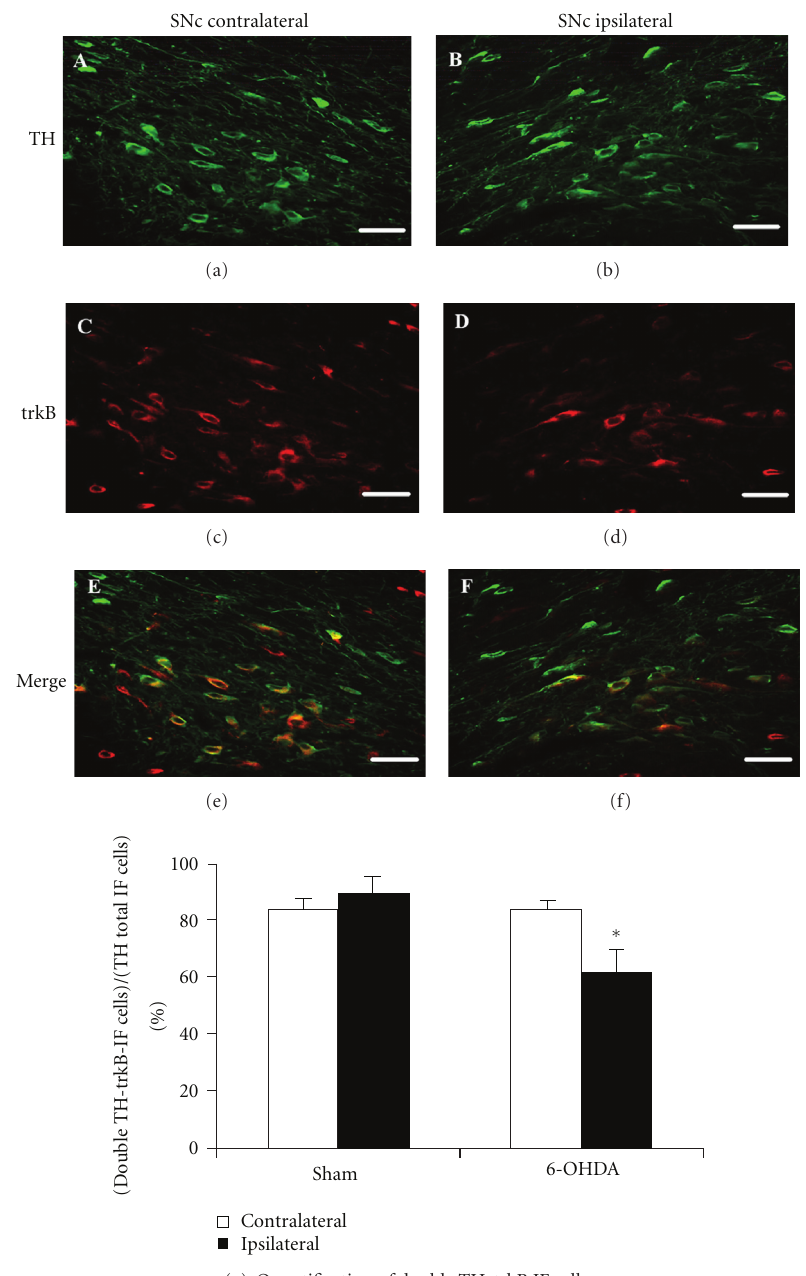
Figure 6: A decrease in the percentage of double labeling for TH and trkB in SNc is detected 7 days after unilateral 6-OHDA intrastriatal injections. Photomicrographs show TH-IF cells (a), (b) and trkB-IF cells (c), (d) in rat SNc, 7 days after unilateral 6-OHDA intrastriatal injection. (e) Merge of (a) and (c); (f) merge of (b) and (d). (a), (c), and (d) correspond to contralateral SNc while (b), ( d), and (f) to ipsilateral SNc. (a)–(f) scale bar = 50 μ m. SNc: substantia nigra pars compacta. (g) Quantification of cells that coexpress TH and trkB in the ipsilateral SNc compared to their contralateral side, 7 days after unilateral 6-OHDA or ascorbic acid (sham) intrastriatal injections to rats. The results were expressed as the percentage of cells that coexpress TH and trkB over the number of total TH-IF cells. Number of cells with TH-IF signals and double TH-trkB-IF signals in contralateral SNc after ascorbate injection was 365 . 1 ± 39 . 7 and 309 . 5 ± 39 . 7 cells/mm 2 , respectively. In the case of 6-OHDA-treated rats, number of cells with TH-IF signals and double TH-trkB-IF signals in contralateral SNc was 333 . 3 ± 23 . 8 and 277 . 7 ± 7 . 9 cells/mm 2 , respectively. n = 4 rats for each experimental condition. The di ff erent experimental groups were compared by a Kruskal-Wallis nonparametric ANOVA, followed by a U -test. ∗ P < 0 . 05 compared with sham - treated